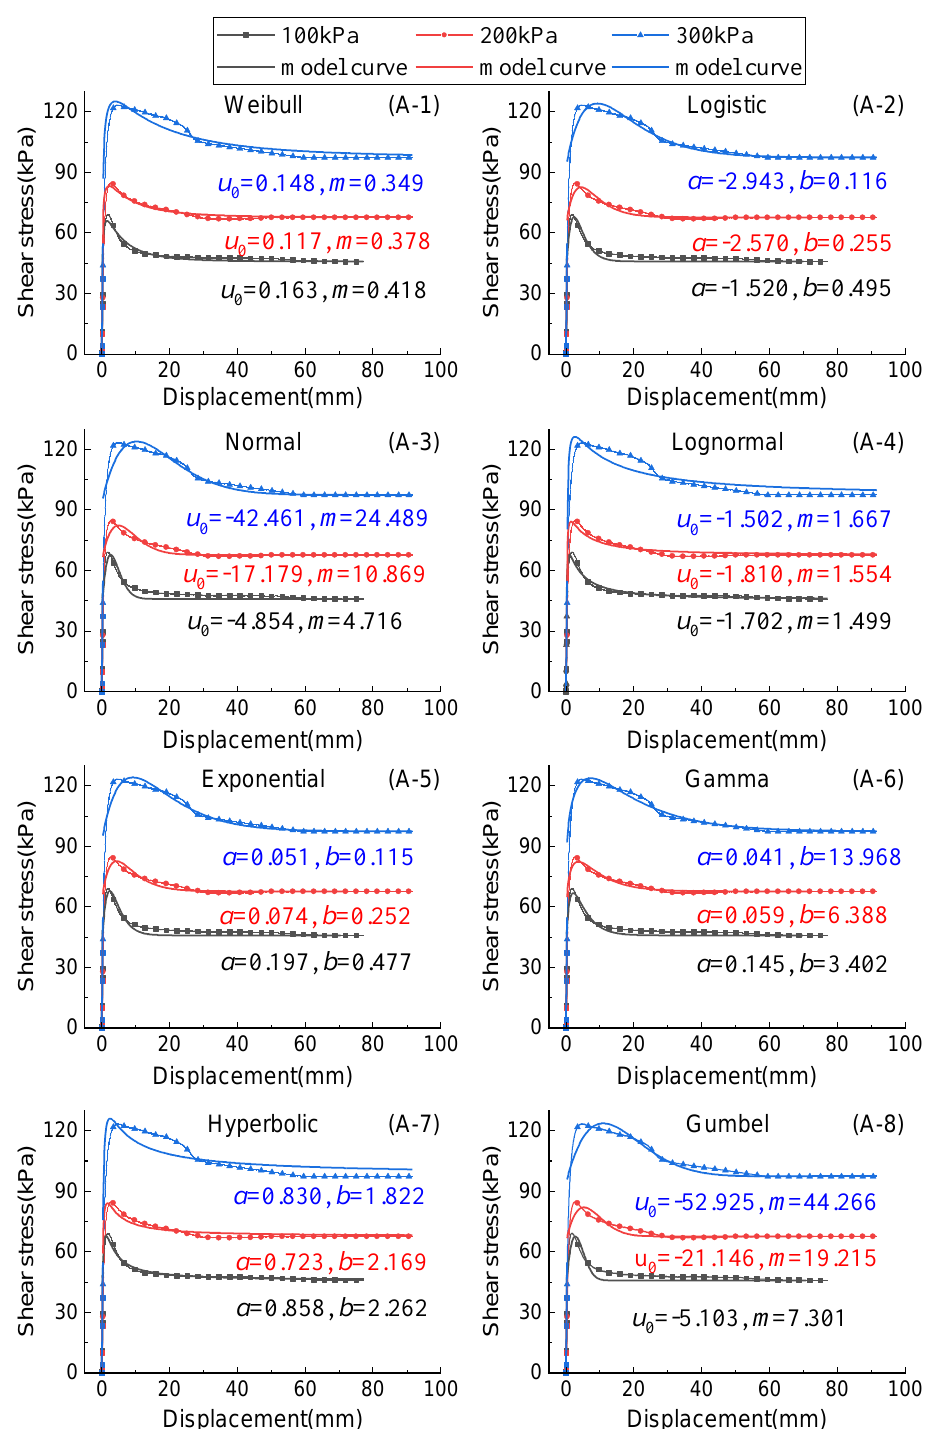
Figure 9. Fitting results of eight constitutive models on weaking softening type of shear curves. Series A presents the model curves and experimental data of the slip zone soil from Huangtupo landslide representing weak softening type. ( A-1 ) Weibull-constitutive model; ( A-2 ) logistic-constitutive model; ( A-3 ) normal-constitutive model; ( A-4 ) lognormal-constitutive model; ( A-5 ) exponential-constitutive model; ( A-6 ) Gamma-constitutive model; ( A-7 ) hyperbolic-constitutive model; ( A-8 ) Gumbel-constitutive model.